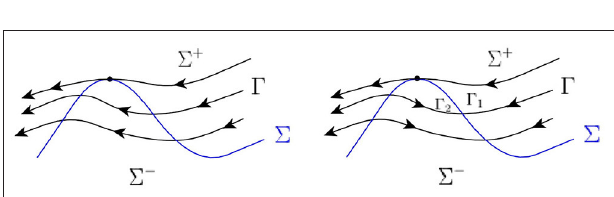
FIGURE 8 | Left: the flow of desingularized ODE system (Equation 27); Right: the flow of the original system. The part of Ŵ lying in 6 − reverses time. The solid points indicate simple fold points where no change of flow direction is